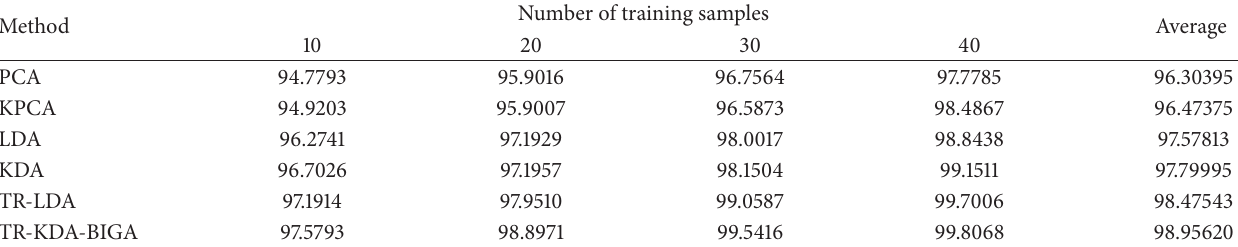
Table 5: Classification accuracy of bearing data under 1HP motor load.